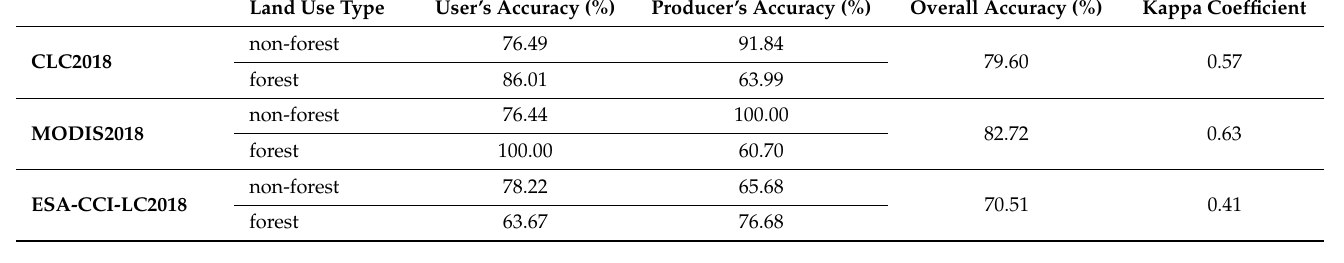
Table 7. Comparison of forest vs. non-forest areas of the three land cover datasets CLC2018, MODIS2018, and ESA-CCI-LC2018 with the KASSANDRA DATASET2018.